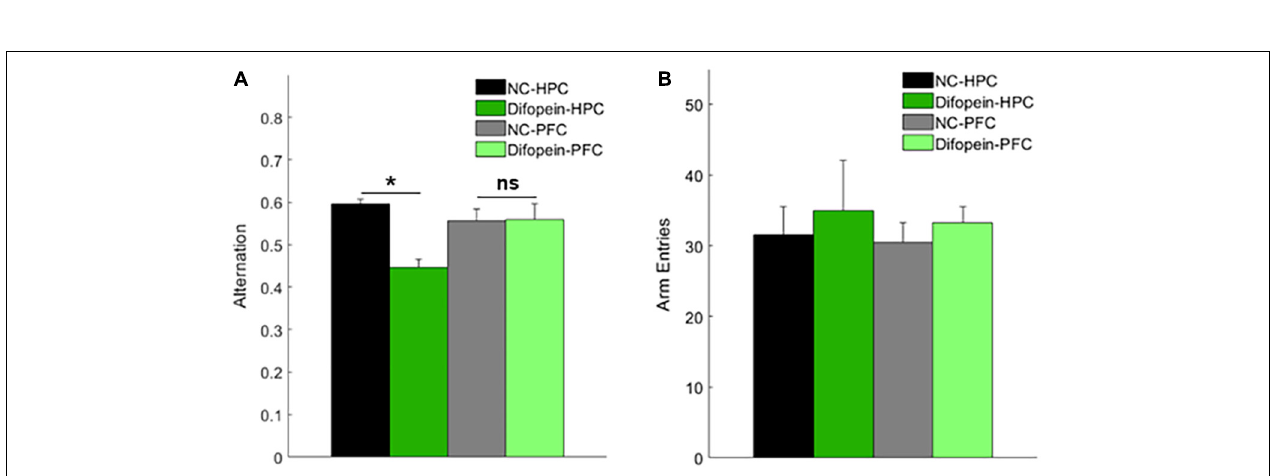
FIGURE 7 | Mice with HPC AAV-YFP-difopein injection (Difopein-HPC, n = 5) alternate significantly less than any other group (NC-HPC, n = 6; NC-PFC, n = 10; Difopein-PFC, n = 8) in the spontaneous Y-maze (A) , indicative of spatial reference memory impairment. There are no significant differences among groups in the number of maze arm entries (B) . Statistical significance denoted as * p < 0.05. ns , not significant.